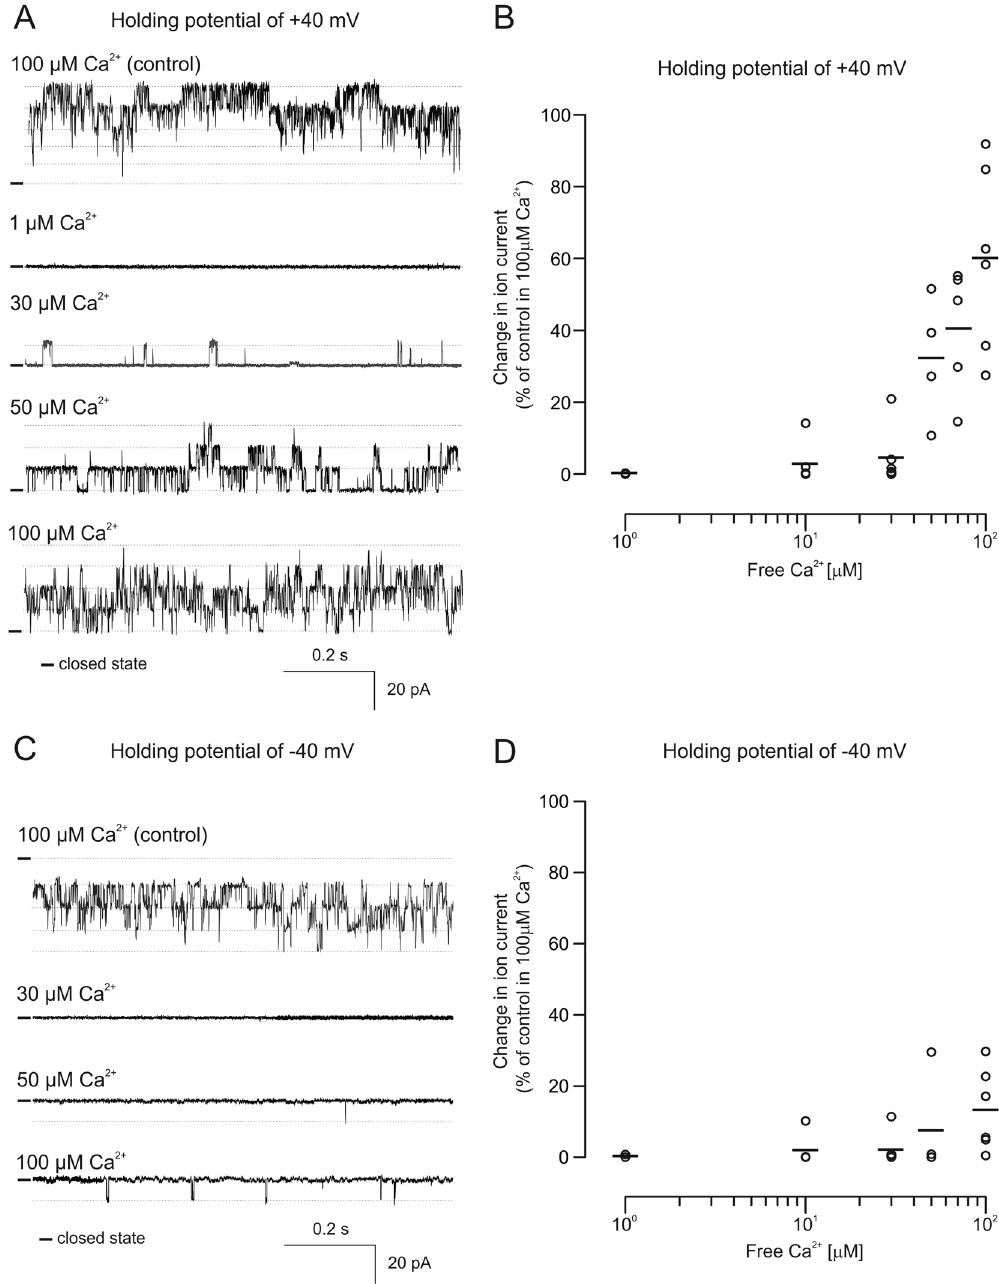
Figure 3. Modulation of the channel activity by calcium ions. ( A ) Sample of the single-channel recordings in symmetrical 150/150 mM KCl solution at different Ca 2+ concentrations at a holding potential of + 40 mV. ( B ) Analysis of changes in the ion current in the presence of various Ca 2+ concentrations recorded at holding potentials of + 40 mV. ( C ) Representative single-channel recordings in symmetrical 150/150 mM KCl solution in the presence of different Ca 2+ concentrations recorded at a holding potential of − 40 mV. ( D ) Analysis of changes in the ion current in the presence of various Ca 2+ concentrations recorded at a holding potentials of − 40